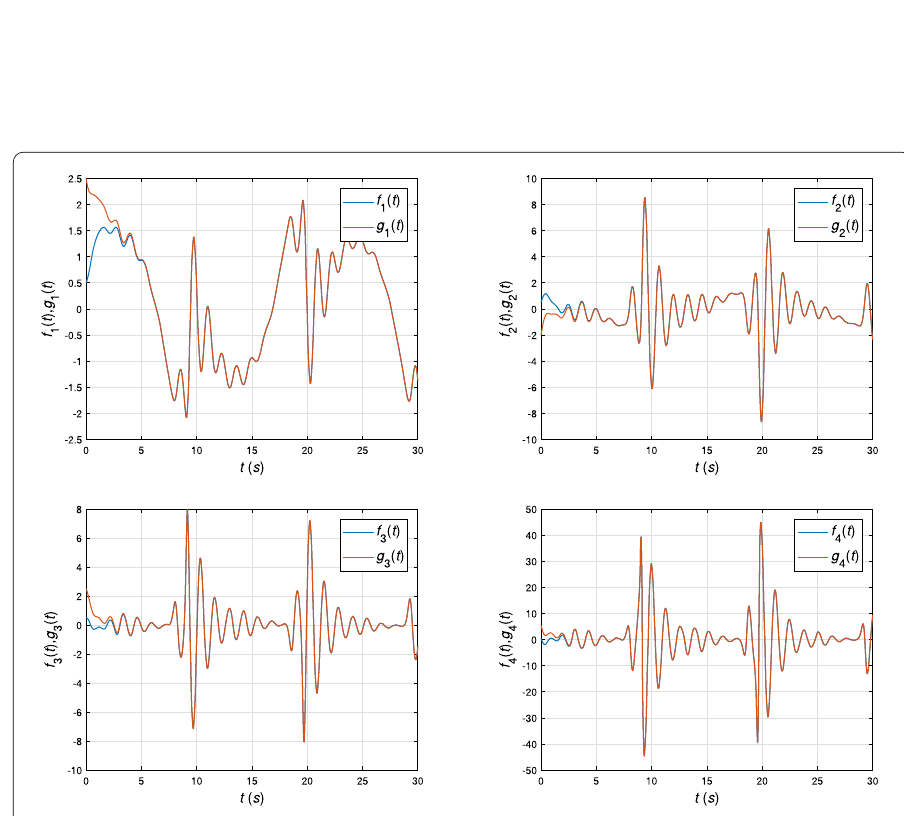
Figure 18 The state trajectories of the synchronized systems (19) and (20) for q =